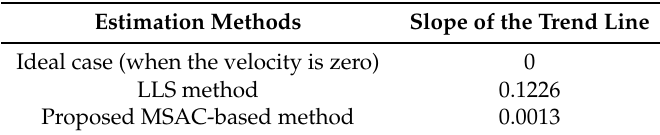
Table 2. Slope of the trend line.